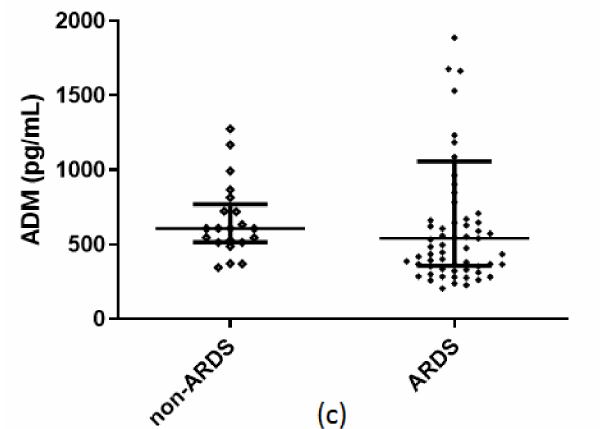
Figure 1. Hospital admission levels of soluble endothelium–related protective molecules in COVID-19 patients. ( a ) eNOS, ( b ) iNOS, and ( c ) ADM were measured in 21 COVID-19 non-ARDS patients and 68 patients with COVID-19-inflicted ARDS on hospital admission (within 24 h). Two–group comparisons were performed with the non-parametric Mann–Whitney test, * p < 0.05. Data are presented as scatter plots, indicating the median value and 25th to 75th centiles. Dashed line, median value of the whole cohort. ADM = adrenomedullin; ARDS = acute respiratory distress syndrome; eNOS = endothelial nitric oxide synthase; iNOS = inducible nitric oxide synthase.